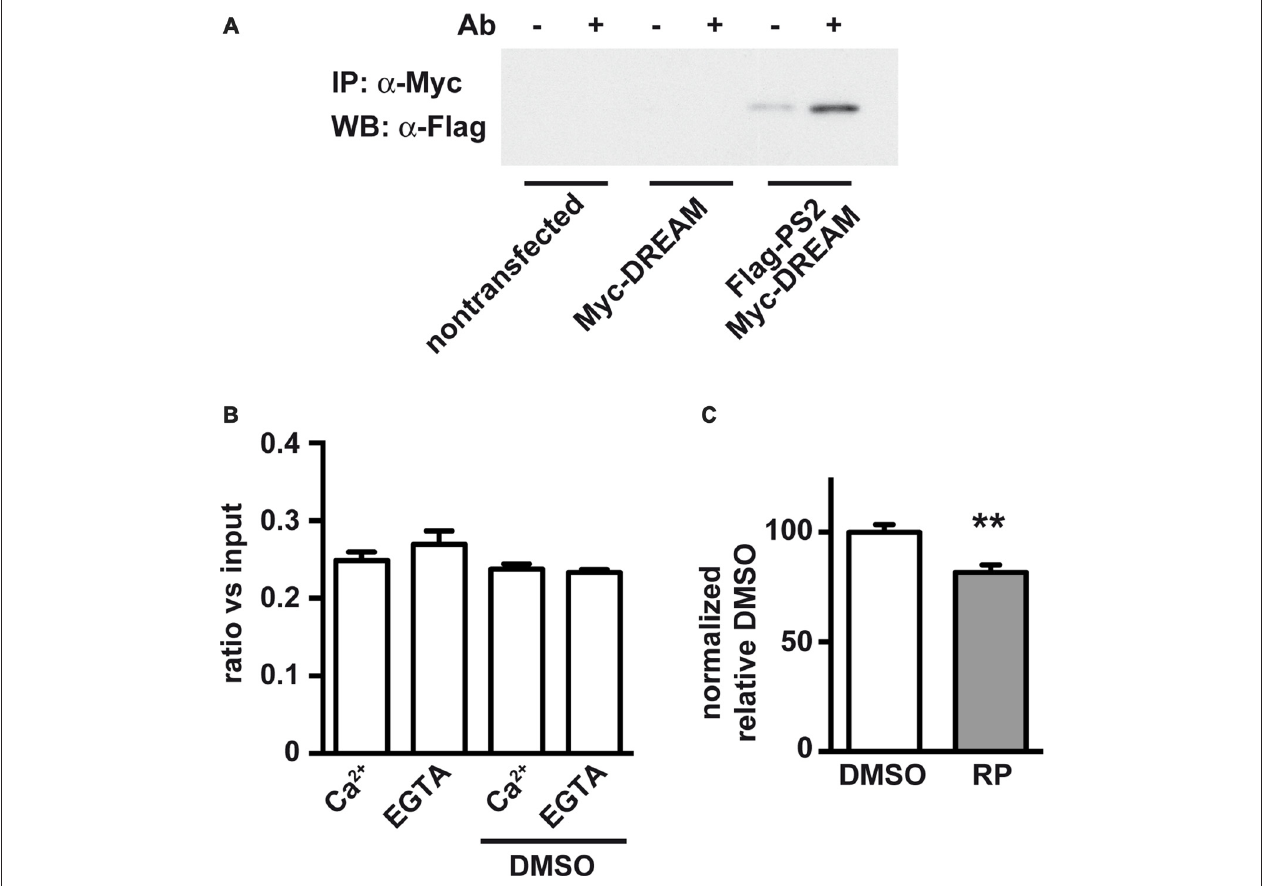
FIGURE 3 | Coimmunoprecipitation of processed carboxy-terminal fragment of PS2 (Ct-PS2) and effect of calcium and the DREAM-binding molecule repaglinide. HEK293T cells were cotransfected with expression vectors for Myc-DREAM and Flag-Ct-PS2. (A) Immunoprecipitation with (+) or without ( − ) anti-Myc and immunoblot with anti-Flag antibody. (B) Immunoprecipitation in the presence or absence of calcium or DMSO, quantified after immunoblot with anti-Flag antibody. The experiment was repeated twice. No differences were observed among groups. (C) Immunoprecipitation in the presence of vehicle (DMSO) or repaglinide (RP), quantified after immunoblot with anti-Flag antibody. Unpaired two-tailed t -test ( n = 10), ∗∗ P <